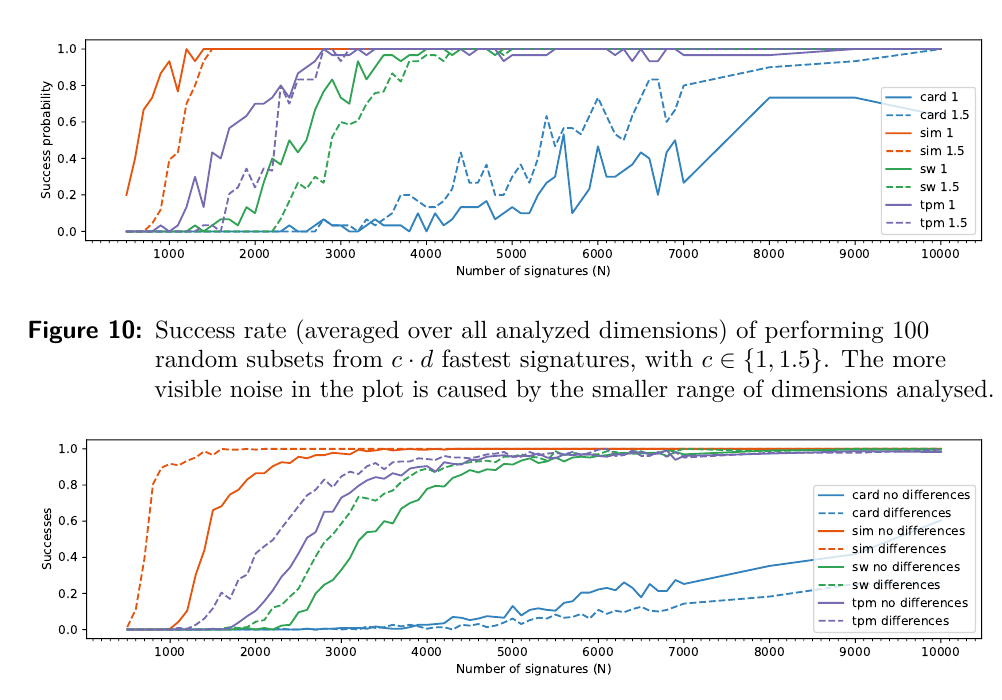
Figure 11: Success rate (averaged over the dimensions) of performing the attack using nonce differences on the various